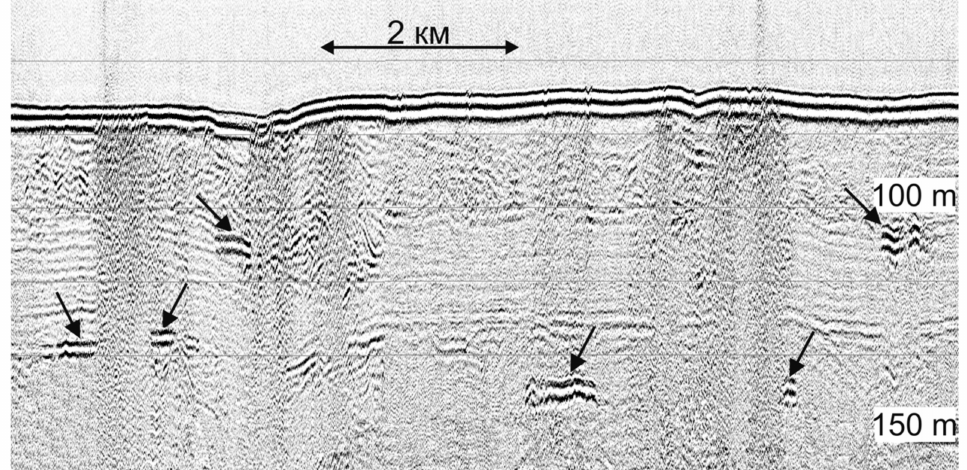
Figure 13. Fragment of the regional profile obtained by CSP system Geont-Shelf in the Laptev Sea. Gas-saturated layers are indicated by